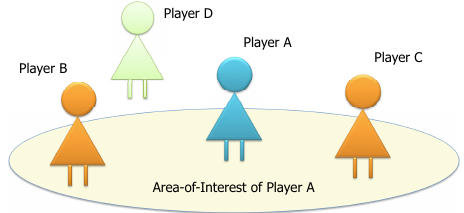
Fig. 1. Area-of-interest of Player A (Players B and C are visible from Player A, but Player D is not).